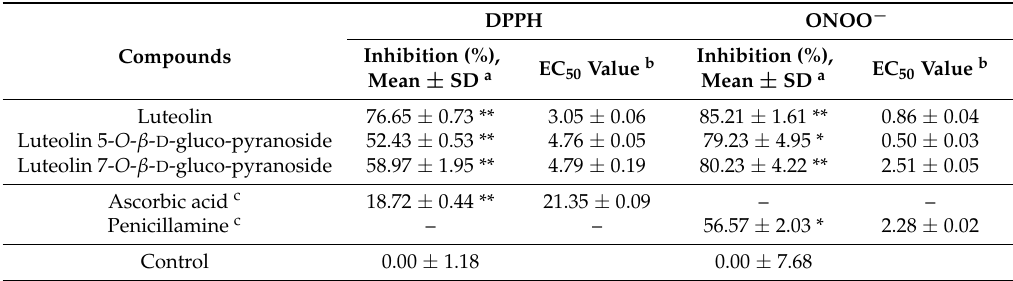
Table 2. Anti-oxidant activity of different isolated compounds from C. maackii .